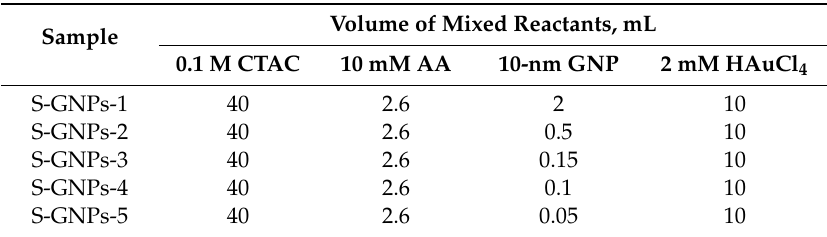
Table 2. Proportions of reactants for the second step of the spherical gold nanoparticle preparation.